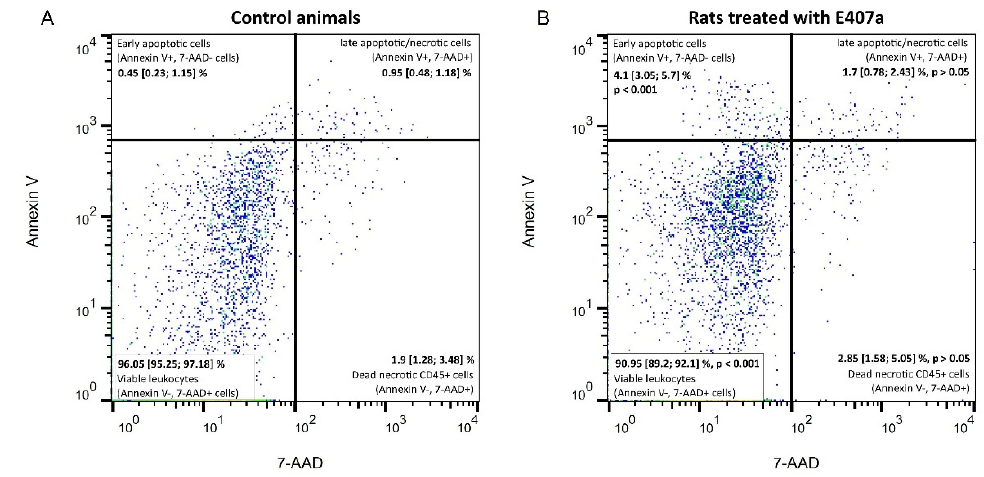
Figure 6. Representative Annexin V/7-AAD dotplots that demonstrate the percentage (Me [IQR]) of viable leukocytes (Annexin V − , 7-AAD + cells); early apoptotic cells (Annexin V + , 7-AAD − cells); late apoptotic/necrotic cells (Annexin V + , 7-AAD + ); and dead necrotic CD45 + cells (Annexin V − , 7-AAD + ) in the control ( A ) and experimental groups ( B ). A statistically significant increase in the percentage of early apoptotic cells is found in rats exposed to semi-refined